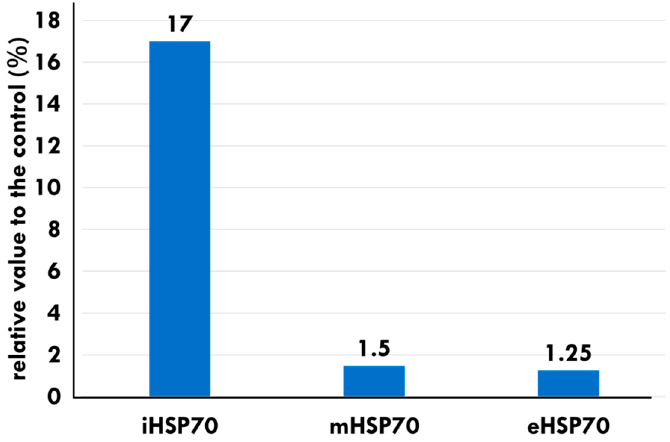
Figure 7. The localization distribution of HSP70s in B16F10 melanoma allografts at 24 h [107]. Massive apoptosis appeared despite increased chaperoning by iHSP70.